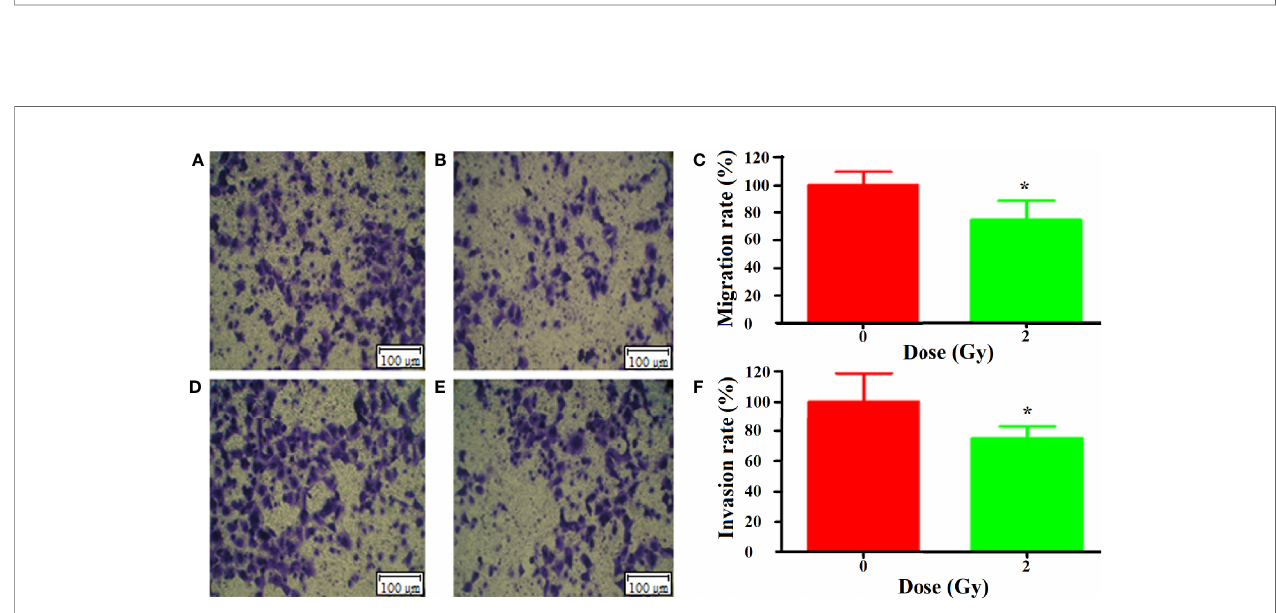
FIGURE 2 | Inhibition of migration and invasion of A549 cells by carbon ions [ (A) migration and invasive staining, (B) metastasis difference analysis] *p < 0.05.